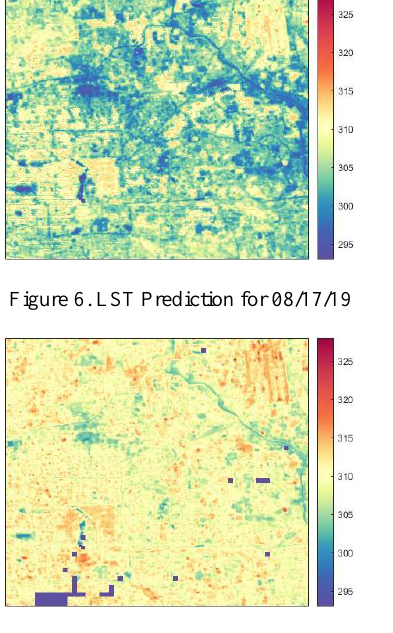
Figure 7. LST Prediction for 09/02/19